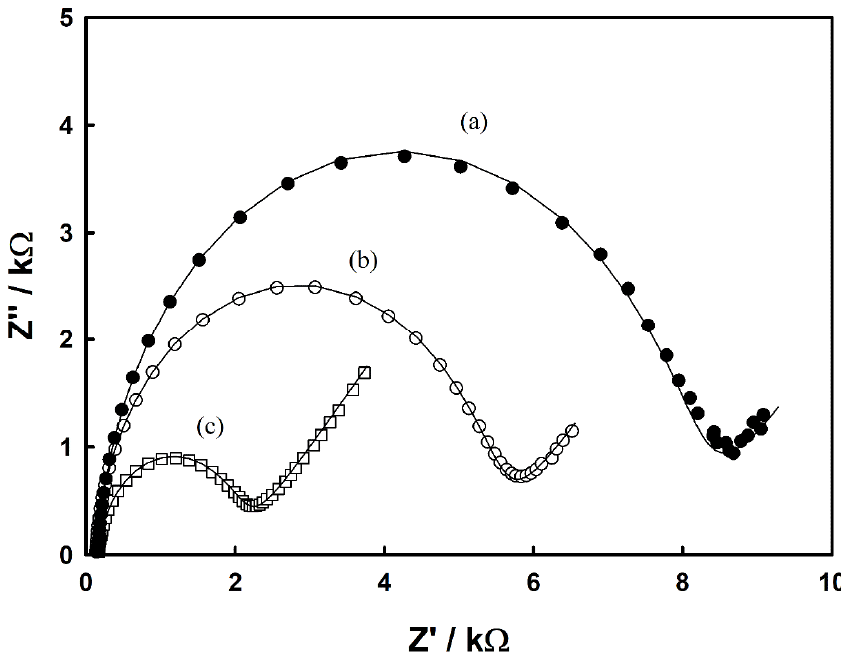
Figure 3. Impedance spectra in the presence of 0.1 mM Fe(CN) 63 − /0.1 mM Fe(CN) 64 − (1:1 molar ratio) and 0.1 M KNO 3 in EB using a different electrode ( a ) before and ( b ) after incubation with 100 nM thrombin as target protein on TBA − SWCNT/SPCE. ( c ) Nyquist plot of SWCNT/SPCE without TBA under the same electrolyte conditions. Solid curves represent the fitting results from an equivalent circuit.